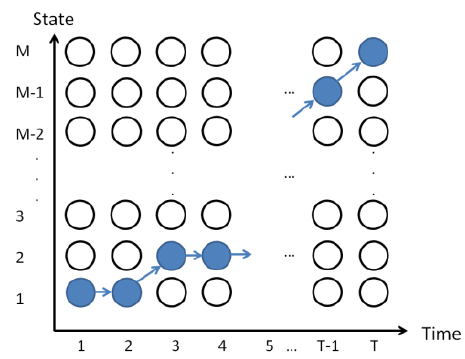
Figure 24. Viterbi algorithm path.